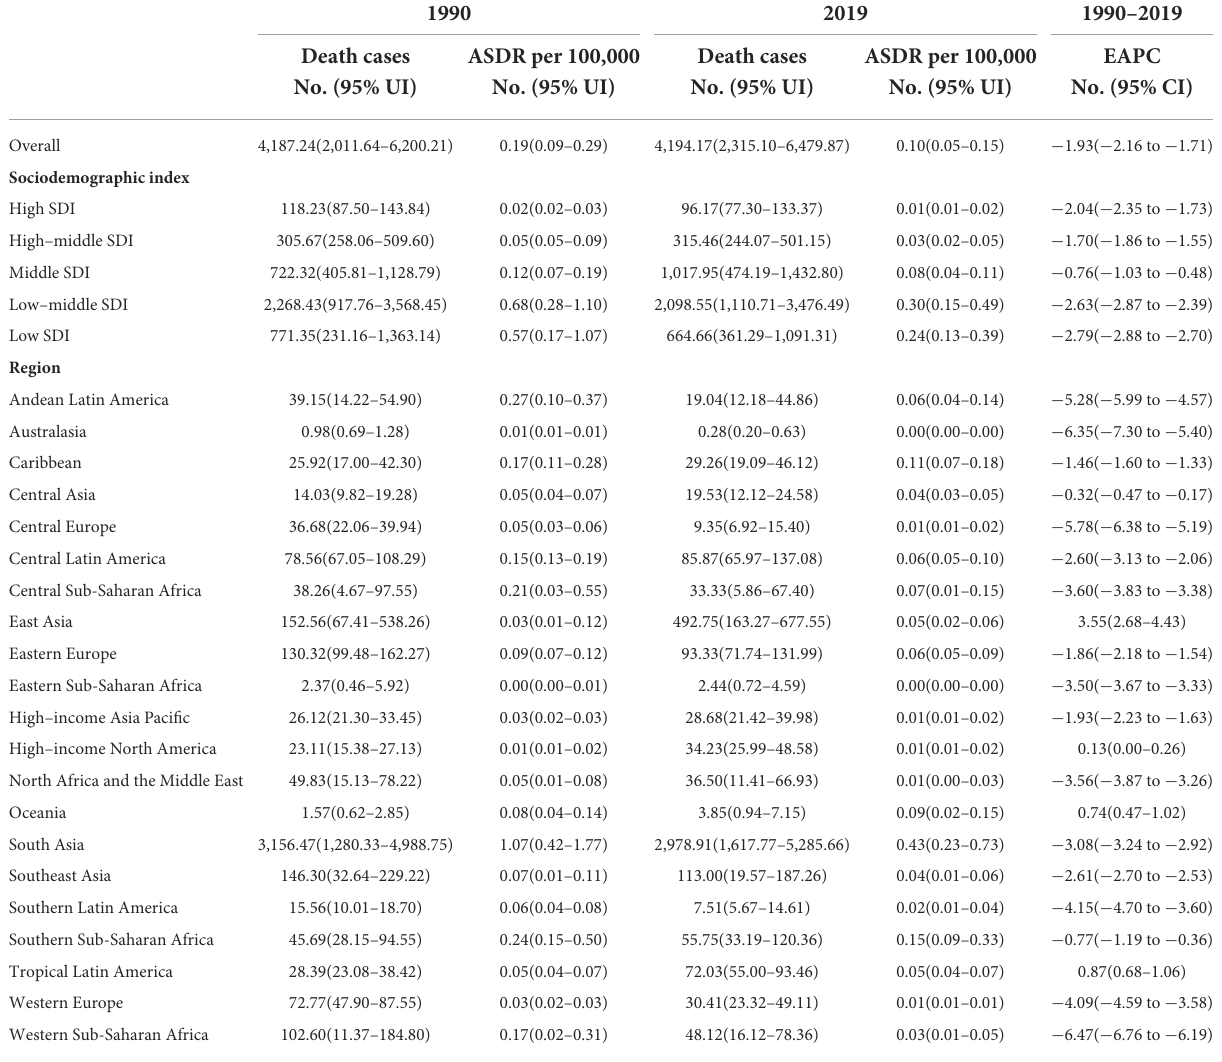
TABLE 2 The death cases and ASDR in 1990 and 2019 and its temporal